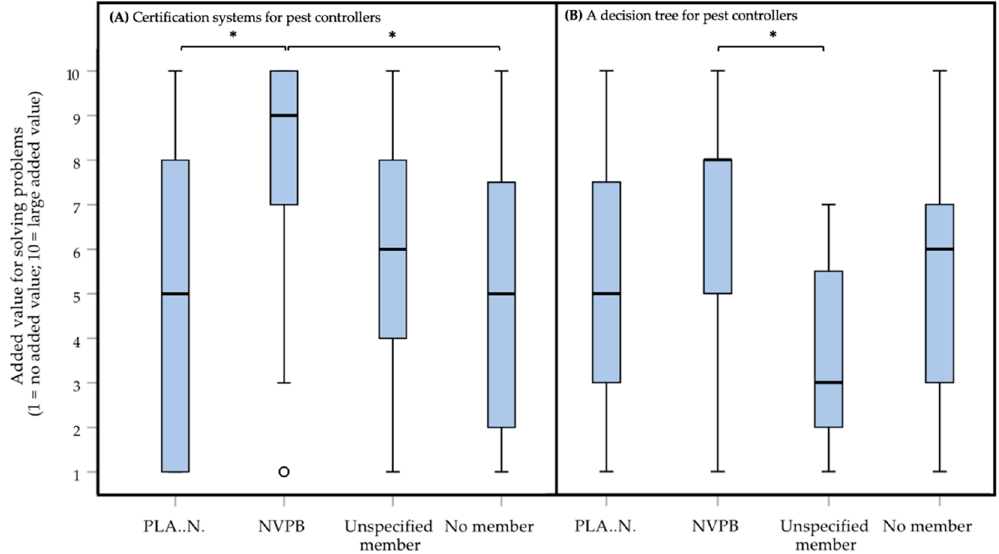
Figure 9. Box plots presenting the added value of different possible solutions (panel ( A ): certification systems for pest controllers; panel ( B ): a decision tree for pest controllers) for problems in practice on a 1 (no added value) to 10 (large added value) rating scale. Solutions were scored by in total 129 Dutch pest controllers, participating in an online survey about the treatment of rats ( Rattus rattus and Rattus norvegicus ) and mice ( Mus musculus ). Outliers are indicated with o. Statistically significant differences between the two types of membership (PLA..N.: n = 40; NVPB: n = 35; Unspecified member: n = 19; No member: n = 35) are indicated with * for each of the panels ( A ) and ( B ).